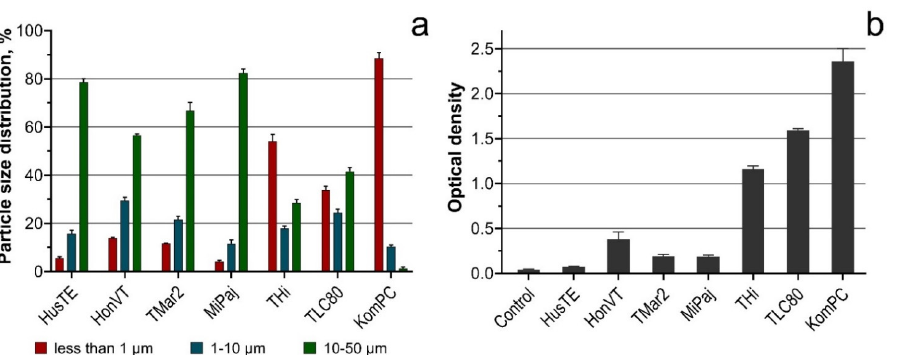
Figure 1. Characteristics of the VEP samples: ( a ) particle size distribution; ( b ) optical density. The PAH content in the stock suspensions of VEP is displayed in Table 3. The highest PAH content was registered in the KomPC sample (>100 ng/mg). Moderate concentrations (>10 ng/mg) were registered for THi and HusTE. Table 3. PAH content in the stock suspensions of VEPs, μ g/L. Sample